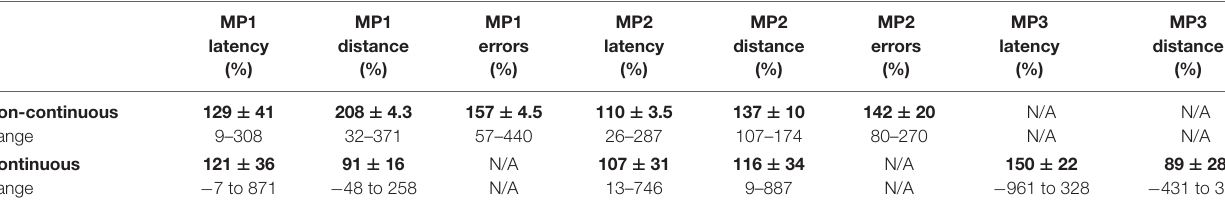
FIGURE 3 | Effectiveness of different motivators for naked mole-rats. (A) Of the motivators tested, home colony bedding, foreign colony bedding, and heat resulted in the shortest latencies to enter the reward chamber compared to an empty chamber. (B) Both home and foreign colony bedding resulted in the greatest increase in dwell time in the reward chamber compared to the start chamber. (C) In assessing the Dwell Time Ratio, animals spent relatively more time in the reward chamber compared to the start chamber when either home or foreign colony bedding was present. A negative percentage indicates more time spent in the reward chamber than the start chamber. ∗ Indicates a significant ( p < 0.05) difference from the empty chamber value. s, seconds. TABLE 3 | Performance comparisons between both maze conformations to assess spatial